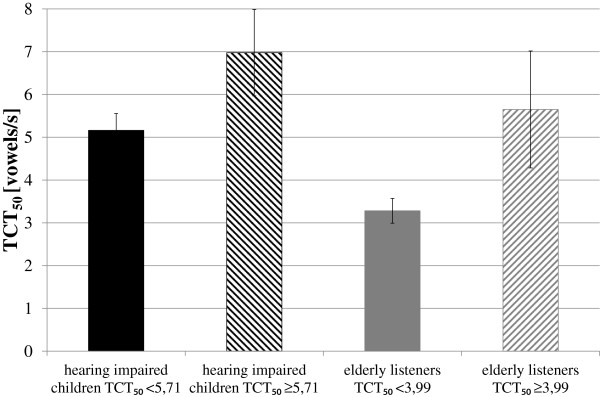
TCT50thresholds for the hearing impaired children and the elderly listeners.